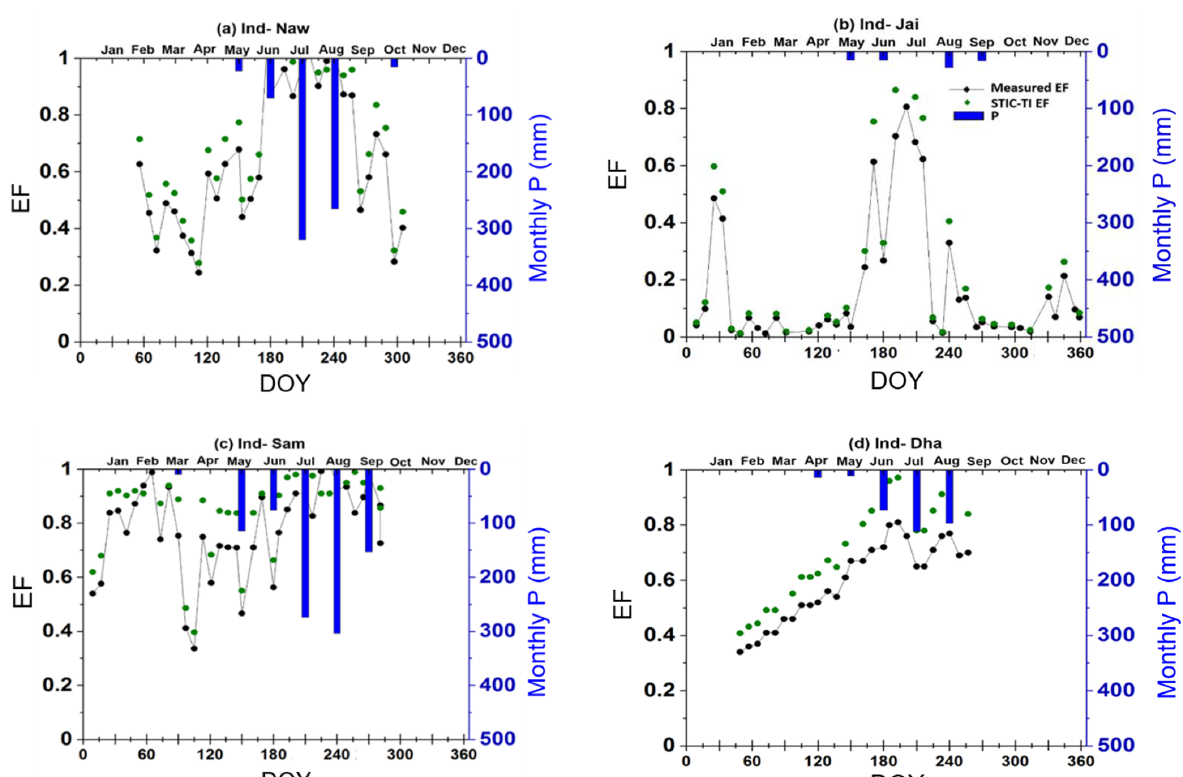
Figure 12. Illustrative examples of the temporal variation of STIC-TI-derived EF using the MYD11A2 LST product with respect to measured EF and P in (a) IND-Naw, (b) IND-Jai, (c) IND-Sam, and (d)